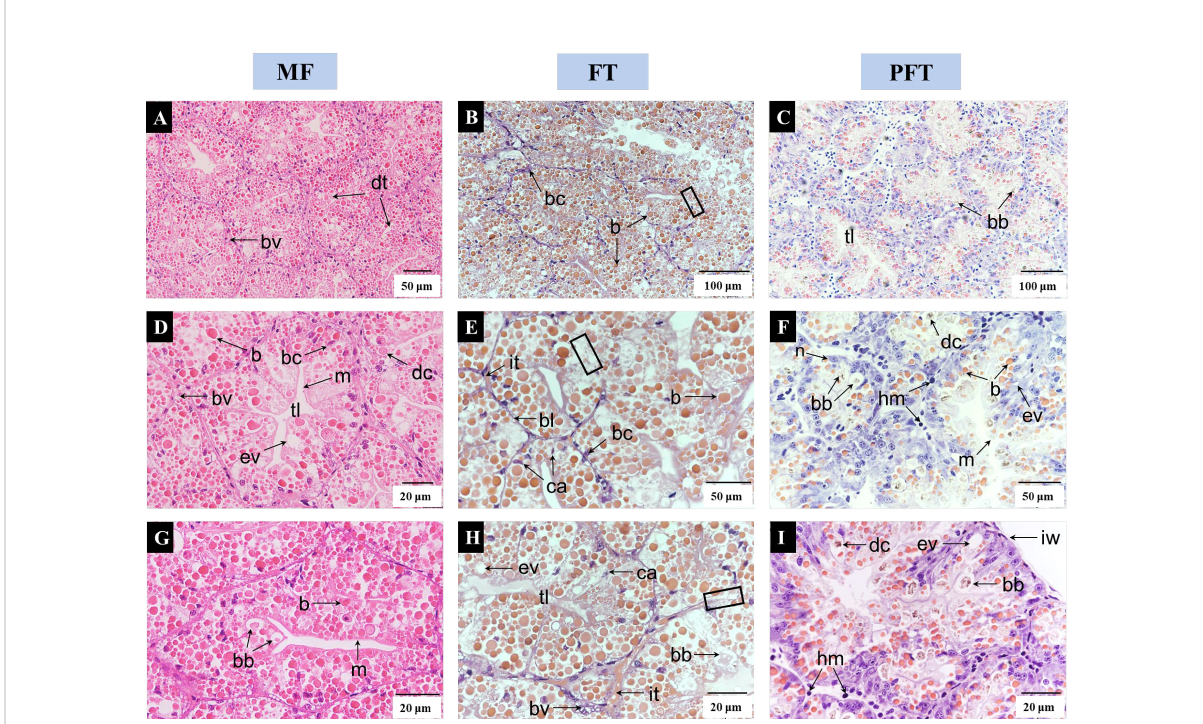
FIGURE 2 Comparative histology of the S. pharaonis digestive gland stained with hematoxylin and eosin (H&E). 20 DPH (A, D, G) , 40 DPH (B, E, H) , and 60 DPH (C, F, I) represent individual digestive tubules at the mysid feeding period (MF), feed transition period (FT), and the post-feed transition period (PFT), respectively. Three distinct cell types are found in the digestive tubule, namely basal cells (bc), secretory cells (the secretions are “ boules ” and “ brownish bodies ” ) and digestive cells (dc). The black border of the digestive gland at 40 DPH indicates that the basal lamina boundary between the digestive tubules was unclear. b “ boules ” (proteinaceous inclusions characteristic of most cephalopods); bb, brownish bodies; bc, basal cells; bl, basal lamina; bv, blood vessel; ca, cell apoptosis; dc, digestive cells; dt, digestive tubules; ev, excretory vacuole; tl, tubule lumen; hm, haemocytes; it, inter-tubular connective tissue; iw, inner wall; m, microvillus; n,